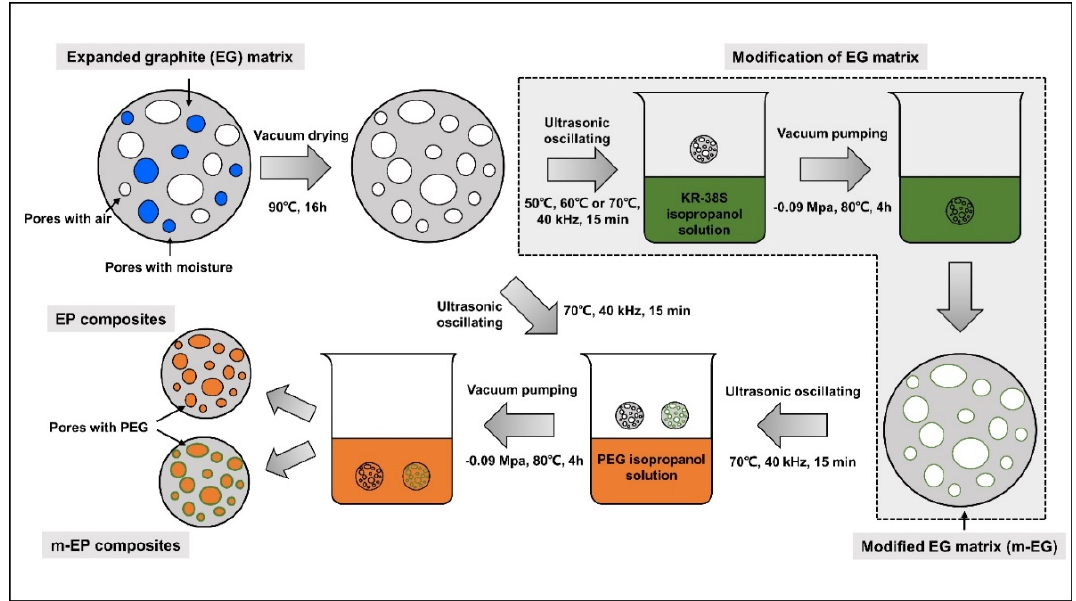
Figure 1. Schematic for the preparation of molecular ‐ bridged EG/PEG composite phase change materials (m ‐ EPs).